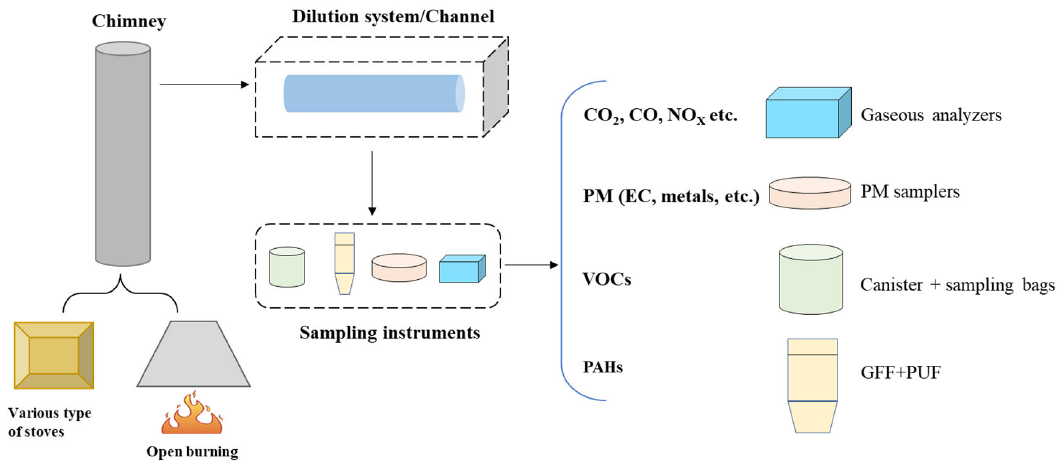
Figure 1. Sampling system of biomass burning (glass fiber filter, GFF; polyurethane foam, PUF). Table 1. Combustion technologies, biomasses, and measurement facilities in